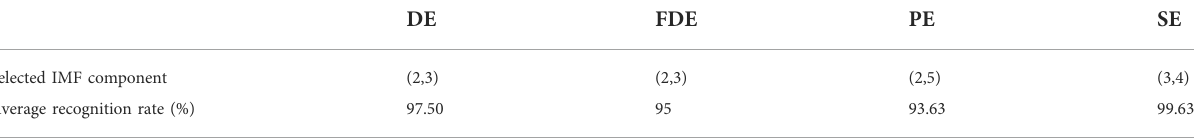
TABLE 3 The highest average recognition rates of the four entropies under dual